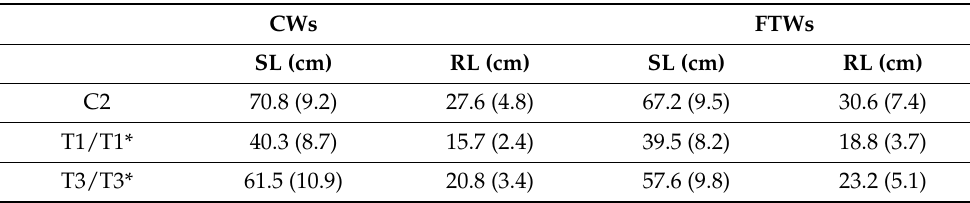
Table 4. Effect of different treatments on the root length (RL) and shoot length (SL) of Phragmites australis vegetated CWs and FTWs.